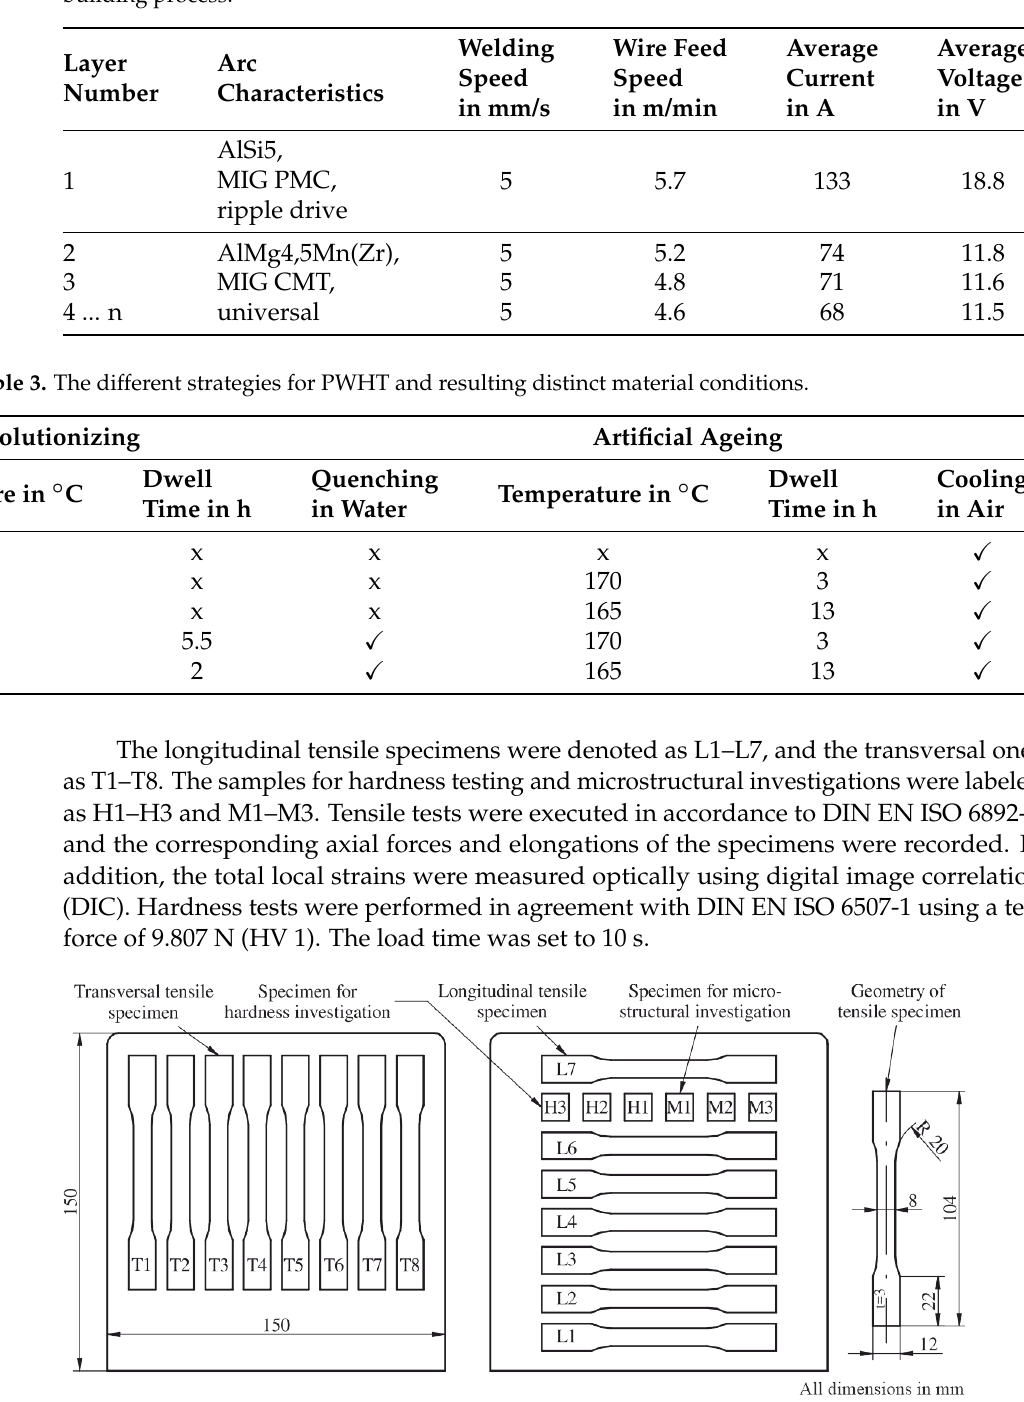
Figure 2. The removal plan and geometry of specimens used for tensile and hardness tests as well as for the analysis of